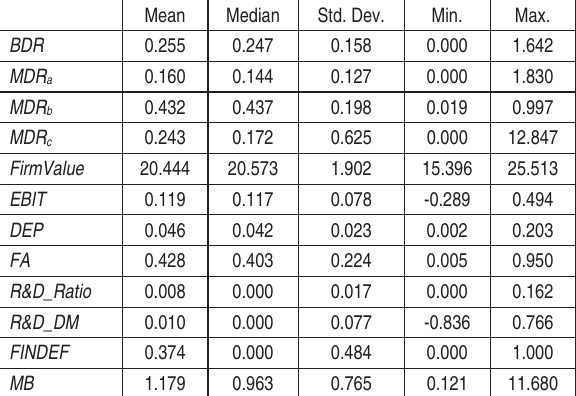
Table 1 (cont.). Summary